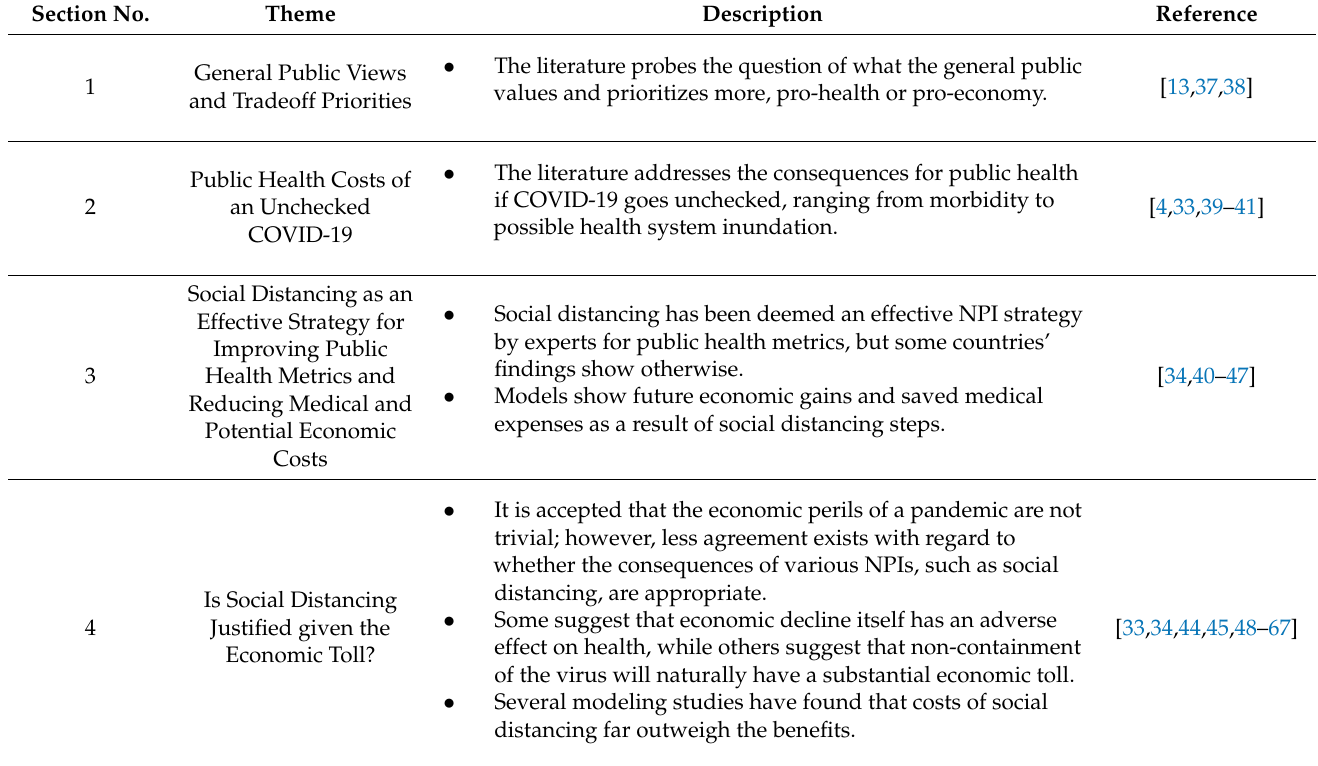
Table 1. Health Economic Dilemma (HED) thematic